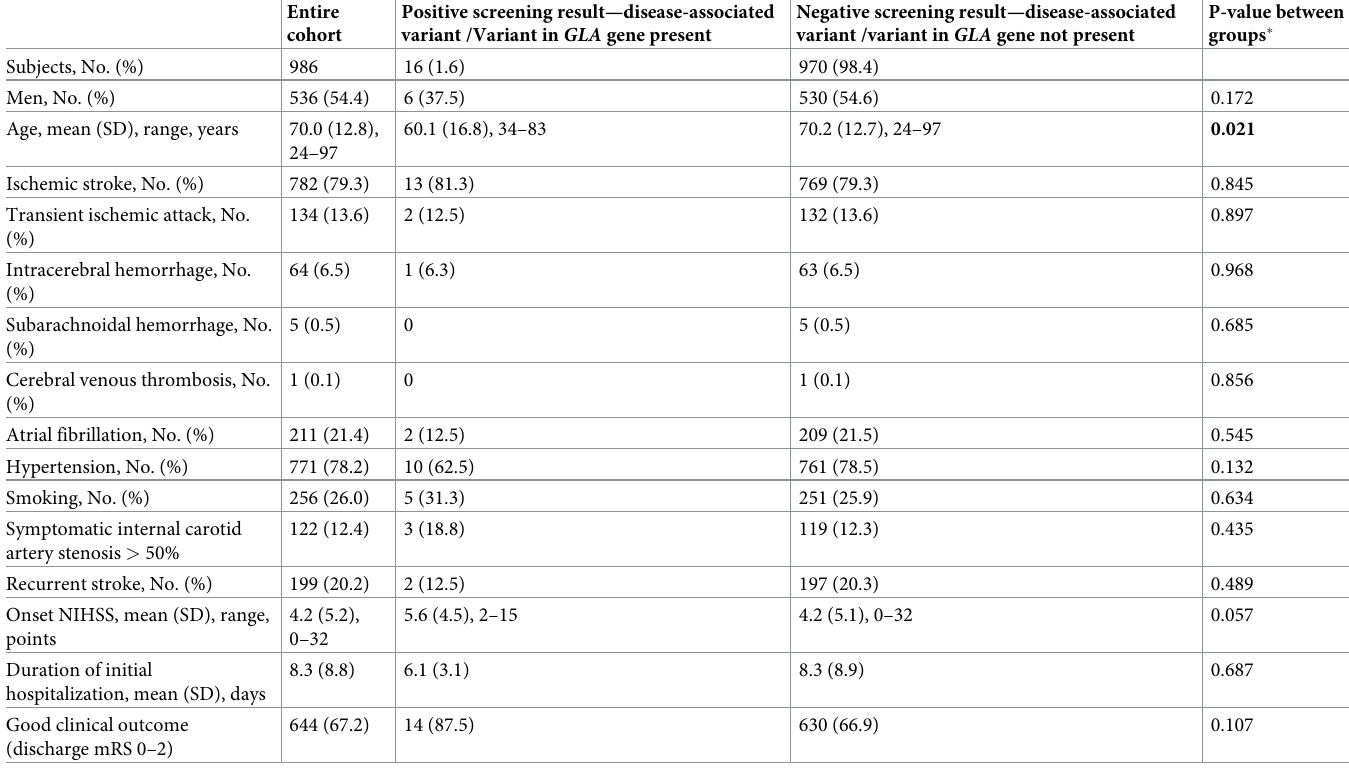
Table 1. Demographic and clinical parameters of screened acute cerebrovascular disease patients.